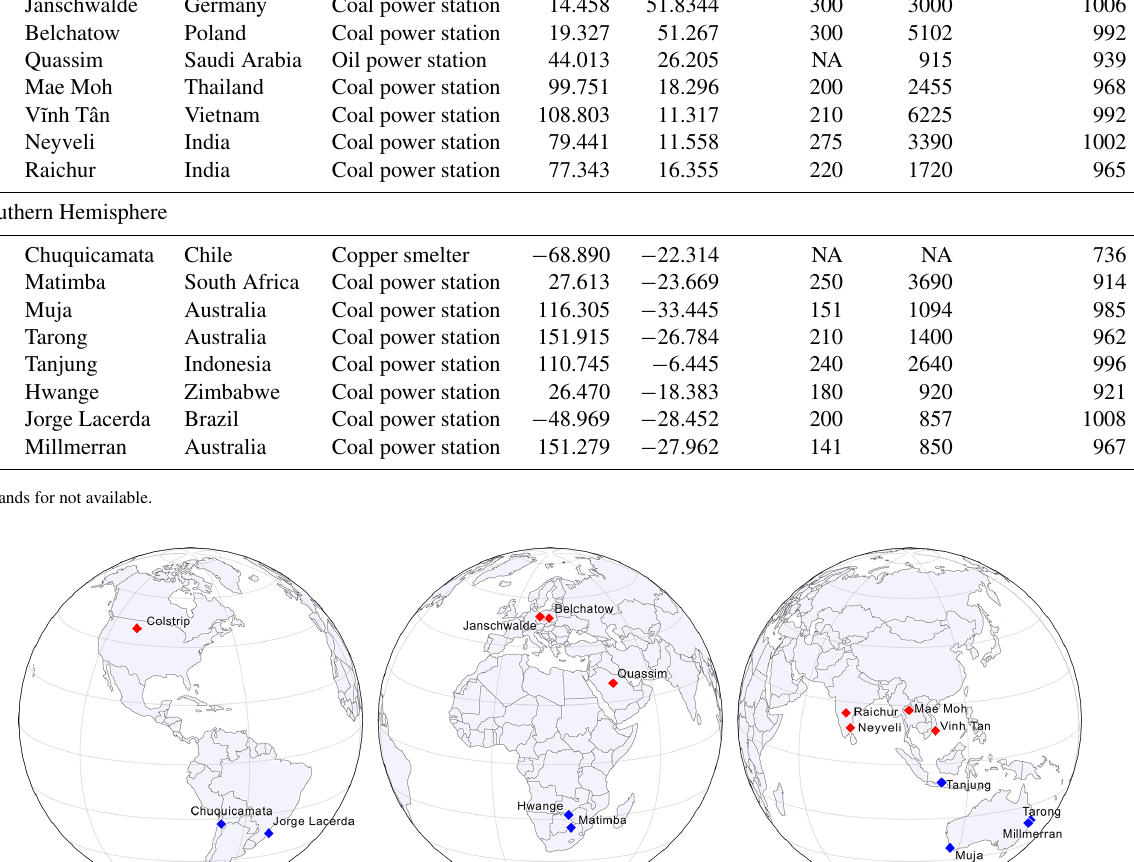
Figure 1. Locations of the sites used in the investigation. Northern Hemisphere sites are shown in red, and Southern Hemisphere sites are shown in